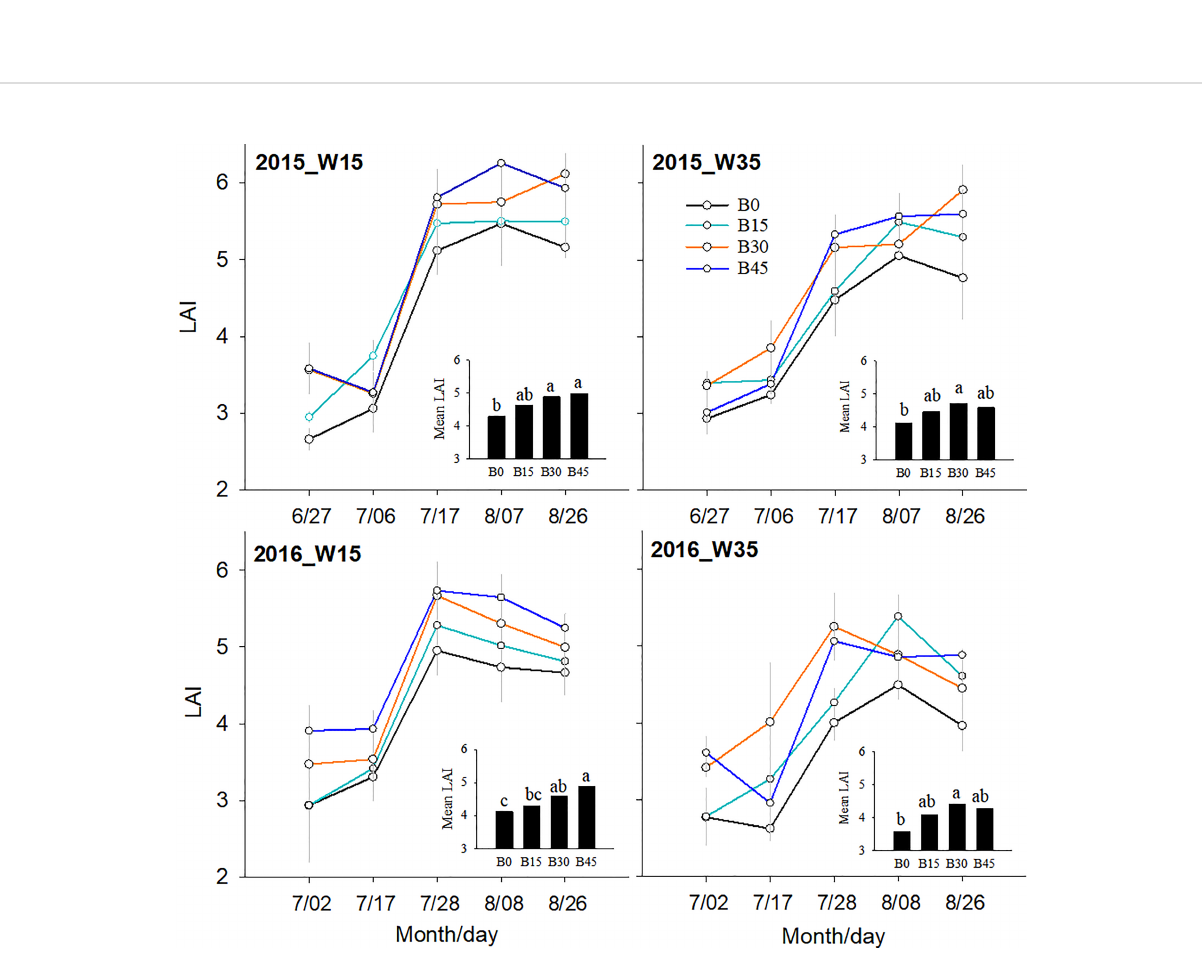
FIGURE 7 Leaf area index (LAI) for biochar amendments (B0, B15, B30, and B45, referring as 0, 15, 30, and 45 t ha -1 ) and irrigation water lower limits at soil matric potential -15 (W15) and -35 kPa (W35). Different lowercase represents signi fi cant difference at P<0.05 between